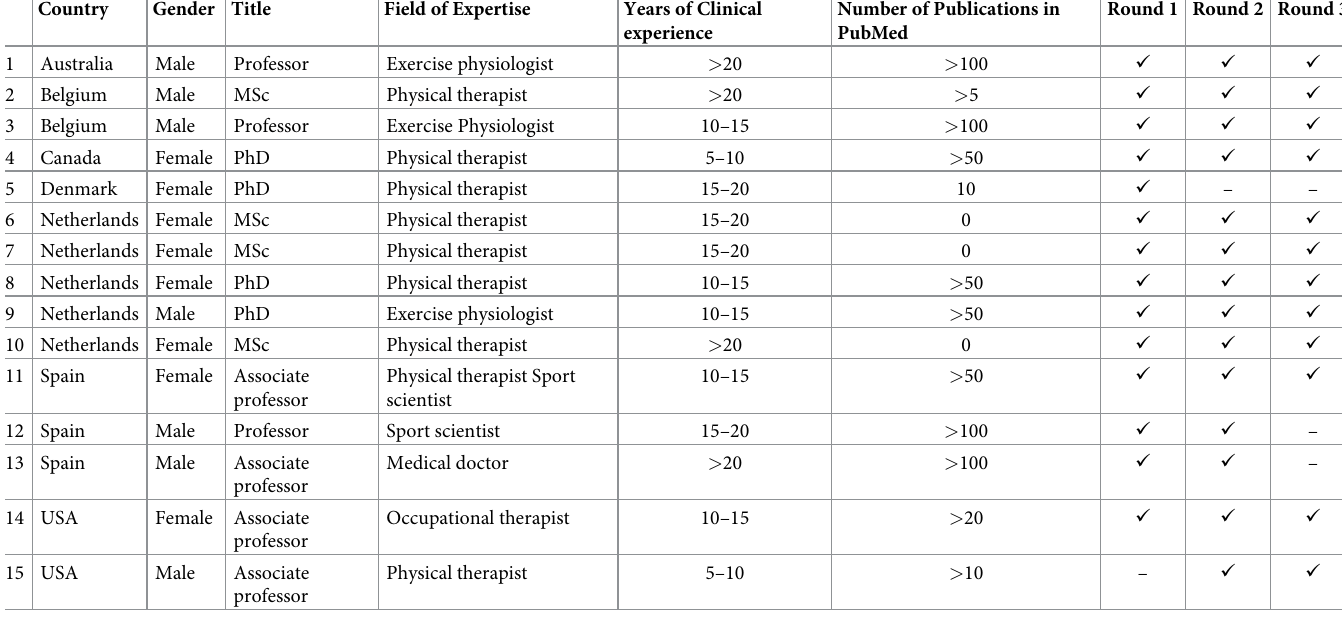
Table 1. International Delphi panel